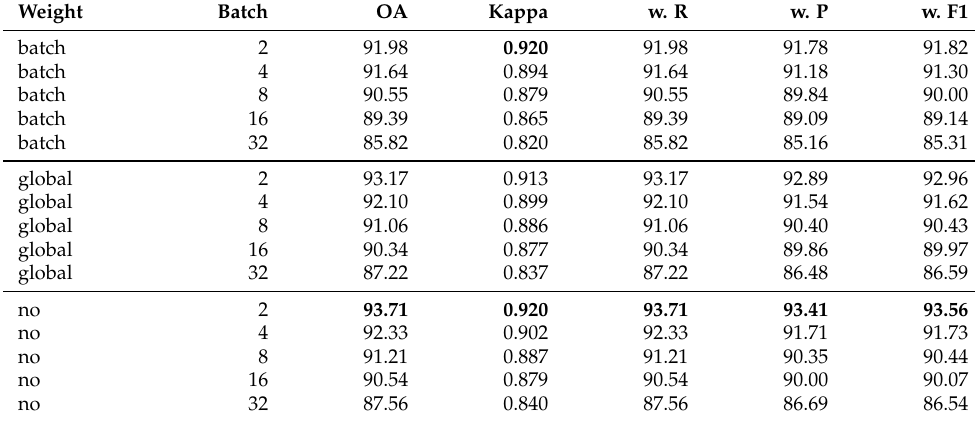
Table 2. Results on Munich validation set to test the effects of the batch size training parameter and three different ways to weight the loss function. Overall accuracy (OA), Kappa and the weighted av- erage measures Recall (R), Precision (P) and F-measure are used to compare two different techniques to handle unbalanced datasets while the batch size is varied between 2 and 32. Weight